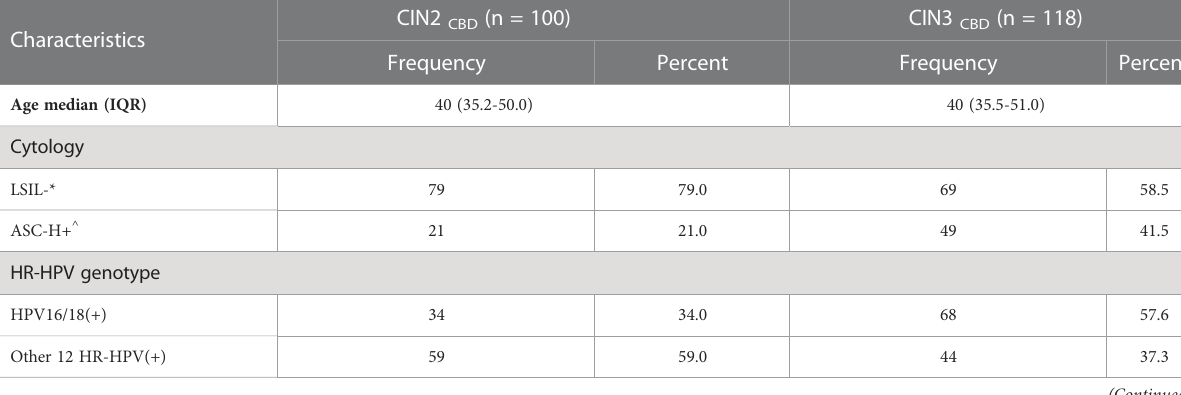
TABLE 1 Characteristics of CDB pathology-con fi rmed CIN2 and